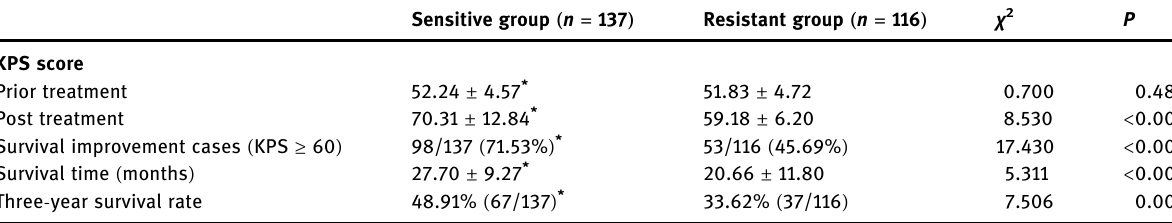
Note: * Sensitive group compared with a resistant group, P <